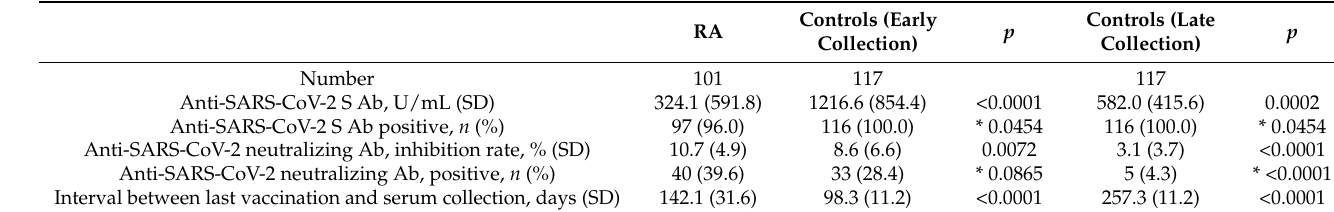
Table 2. Anti-SARS-CoV-2 Abs of RA patients and